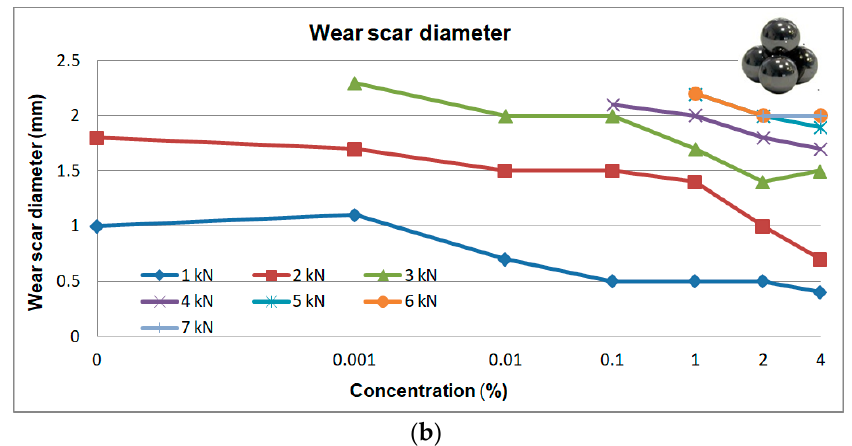
Figure 8. Dependence of coefficient of friction (µ) ( a ) and wear scar diameter (d) ( b ) as a function of load for water and aqueous solutions of sodium lauroyl sarcosinate (SLS). Tribological tester T02, spindle speed of 200 rpm, test duration 900 s.